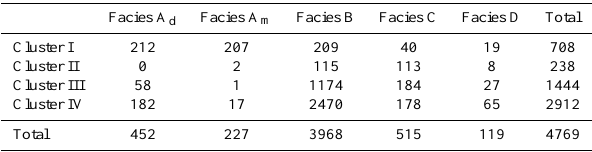
Table 1. Amount of data points of the 6 facies types in the 4 clusters (mass movement deposit sediments and tephra were omitted in this